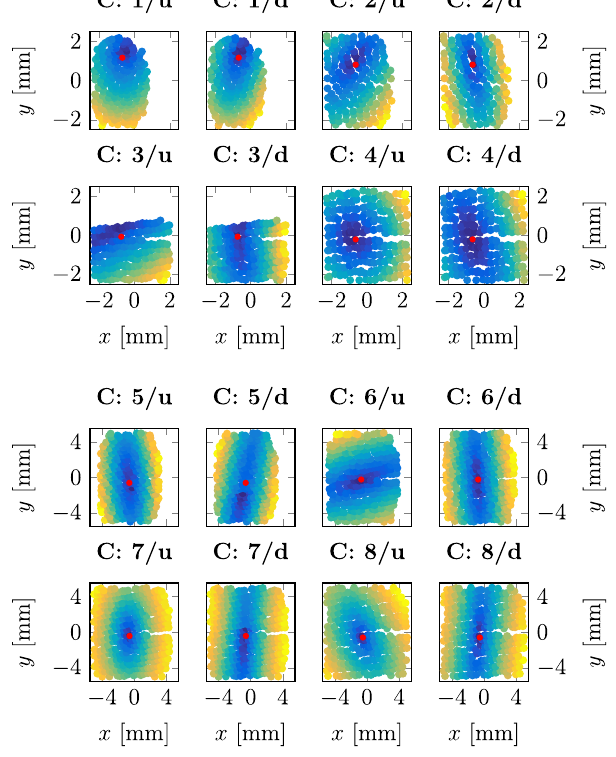
FIG. 14. Normalized power of the dipole mode as measured at each coupler at the injector module at FLASH as a function of beam offset x and y . The upper left plot shows the upstream coupler of the first cavity, C ∶ 1 =u , for example, and the lower right plot the downstream coupler of the eighth cavity, C ∶ 8 =d . The dots are color coded by the relative signal strength, giving a bright yellow point at 1 and a dark blue point at 0. The red dots indicate the fitted cavity centers. Note the unequal axes limits for cavities 1 – 4 and 5 – 8.